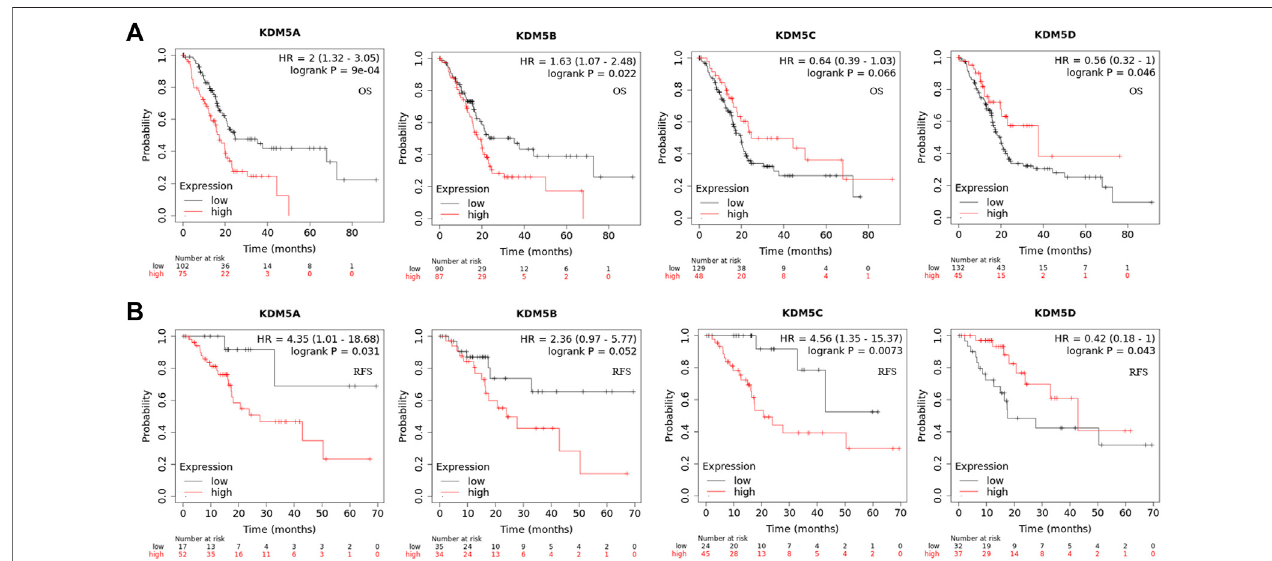
FIGURE3| GeneexpressionlevelofandprognosticcharacteristicsassociatedwiththeKDM5familyinpatientswithPAAD. (A) UpregulatedexpressionofKDM5A isassociatedwithshorter OS/DownregulationofKDM5Dexpressionissigni fi cantlycorrelatedwithshorterOS; (B) UpregulatedexpressionofKDM5Aisassociatedwith shorter RFS/Downregulation of KDM5D expression is signi fi cantly correlated with shorter RFS.